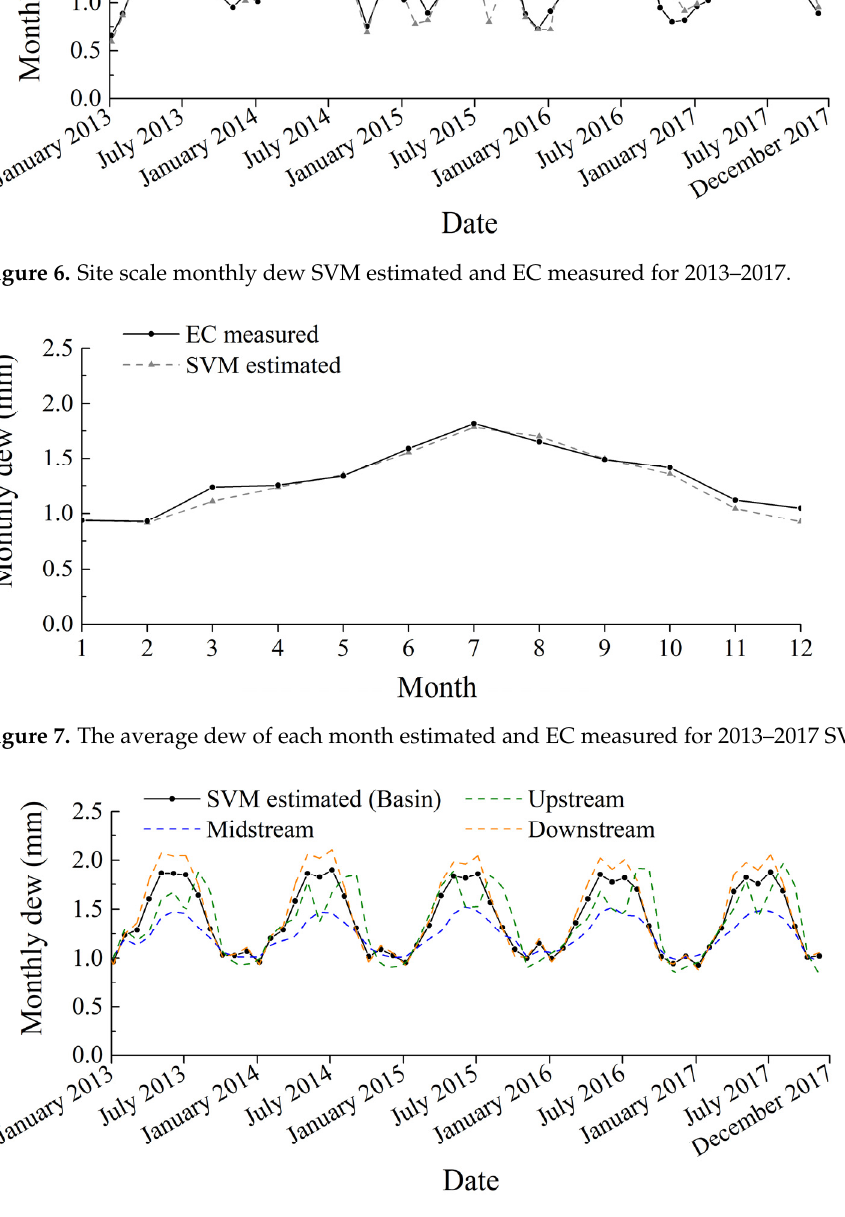
Figure 9. Basin-scale average dew of each month for 2013–2017 estimated using SVM. The distribution of the annual dew yield estimated by the m62 model in the HRB is shown in Figure 10. The annual dew yield across the HRB was found to range from 8.83 to 20.28 mm, with less dew in the upstream and midstream regions, along the river, and in the downstream tailrace. The lower reaches were found to have relatively high dew levels. The average annual dew in the HRB was 16.65 mm/year. High-altitude, riverine, and crop areas have relatively low amounts of dew, while large areas of bare land down- stream have relatively high amounts of annual dew.